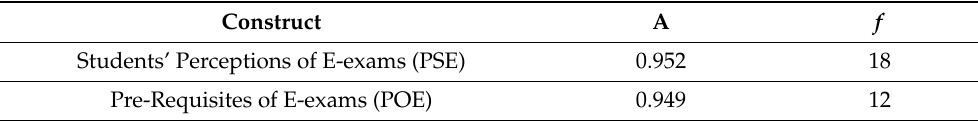
Table 2. Reliability Analysis.